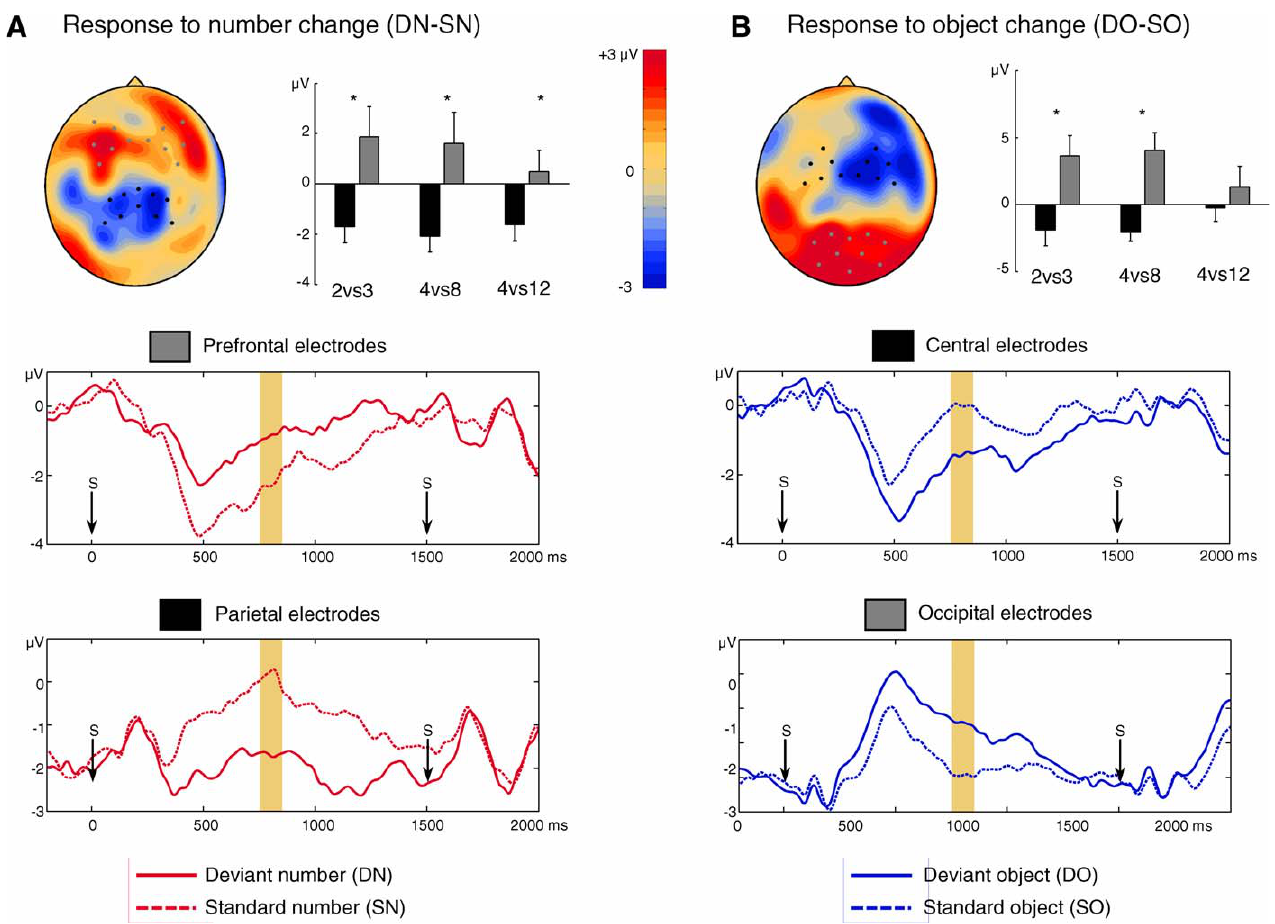
Figure 2. Scalp-Measured Responses to Number Change and to Object Change (A and B) Upper panels show the topography of the difference between the deviant and standard conditions, averaged between 750 to 850 ms after stimulus onset ([A] shows the response to number change; [B] shows the response to object change). Dots mark the location of the electrodes used for ANOVA. Histograms depict effect sizes averaged across these electrodes, for three different groups of infants respectively exposed to numbers two versus three, four versus eight, or four versus 12 (an asterisk [*] indicates p , 0.05). Lower graphs show the time course of voltage averaged over the groups of electrodes used in the ANOVAs. Arrows indicate stimulus onsets (every 1,500 ms).